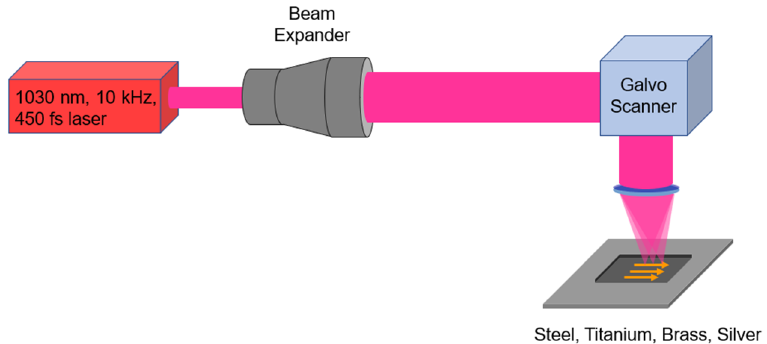
Figure 1. Schematic of the experimental setup: the beam is expanded and then focused on the surface of a metallic workpiece by a galvo scanner equipped with a 100 mm f -theta lens. A linear polarization parallel to the scanning direction (orange arrows) has been used. The inset shows the usual raster scanning pattern with a spot diameter of 2 ω = 26 µ m and a spacing of Λ x = Λ y = 3.64 µ m, yielding a spatial pulse overlap OL = 86% in both x and y directions.